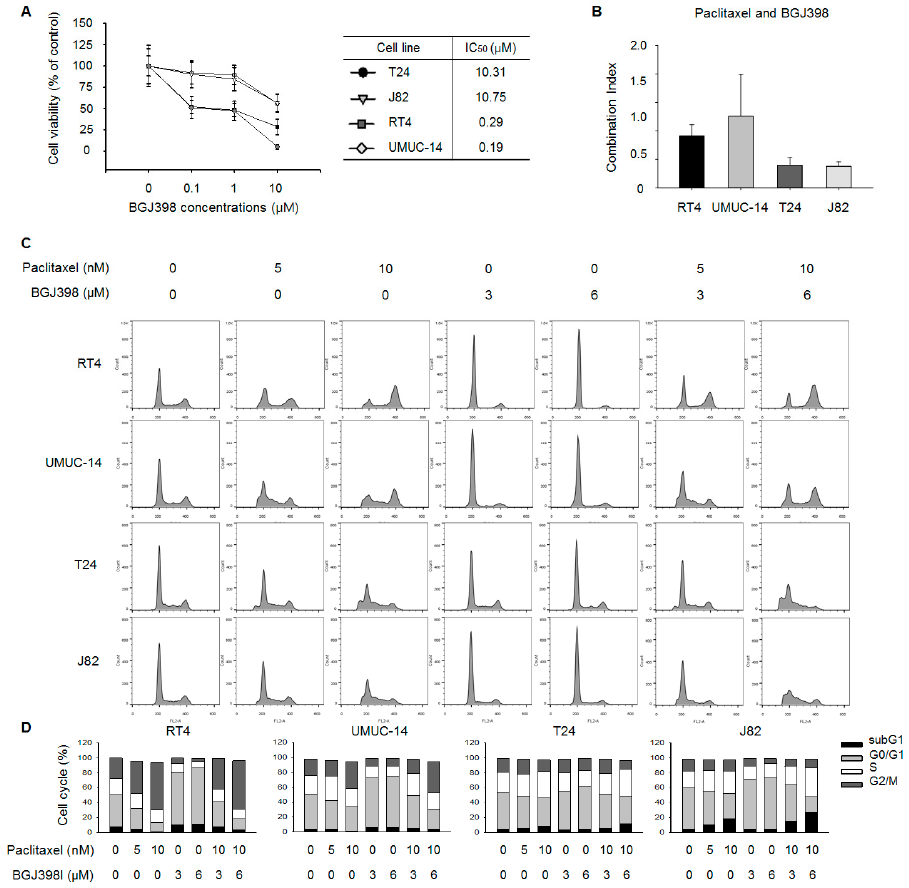
Figure 3. FGFR inhibition enhances PTX-induced cell cycle arrest in mesenchymal-type UC cell lines. ( A ) T24, J82, RT4, and UMUC-14 cells were treated with 0, 0.1, 1, and 10 µ M BJG398 for 3 days. IC 50 values were calculated using CalcuSyn (BioSoft, Ferguson, MO, USA). Data represent mean ± standard deviation of five replicates. ( B ) Cells were exposed to increasing concentrations of PTX and BGJ398 combinations at a fixed ratio. Viable cells were assayed and CI was calculated using CalcuSyn software. Lines above each bar represent CI for that dose combination ( n = 3). ( C ) Cell cycle distribution and apoptosis were analyzed by propidium iodide staining and flow cytometry. A total of 1 × 10 6 cells were seeded in a 60-mm plate and treated with indicated concentrations of PTX and BGJ398 for 48 h ( n = 3). ( D ) Quantification of cell cycle distribution of T24, J82, RT4, and UMUC-14 cells. Treatment with PTX alone caused S phase accumulation and decreased G0/G1 and G2/M